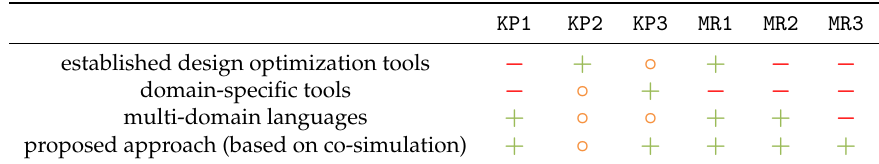
Table 2. Comparison of modeling and simulation approaches in view of key prerequisites and modeling